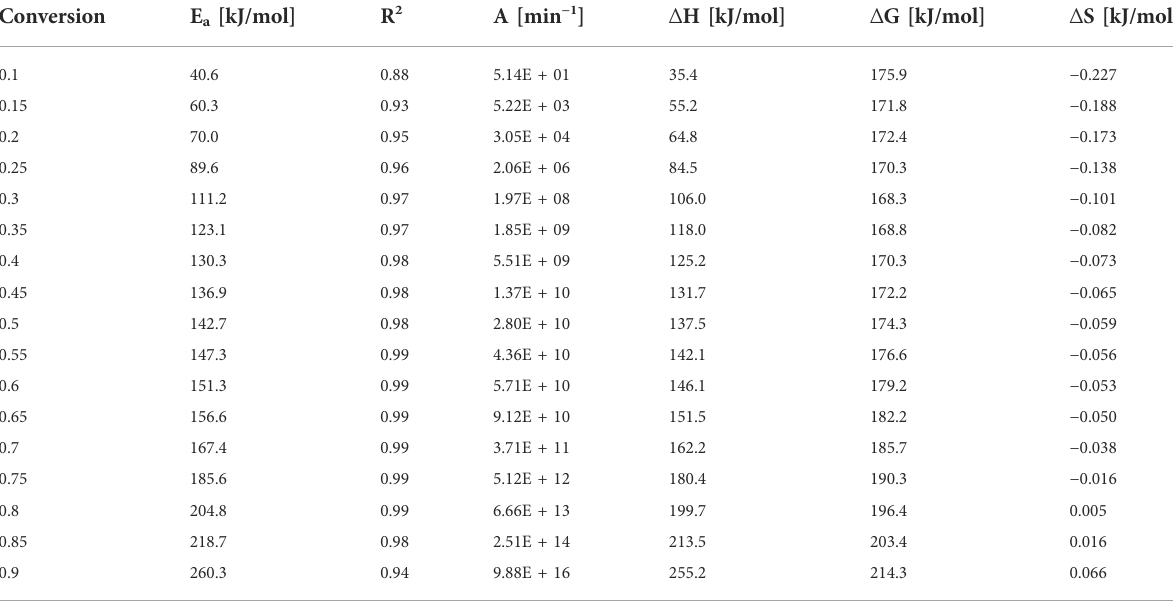
TABLE 3 G. pectorale thermodynamic parameters by Flynn-Wall-Ozawa (FWO)